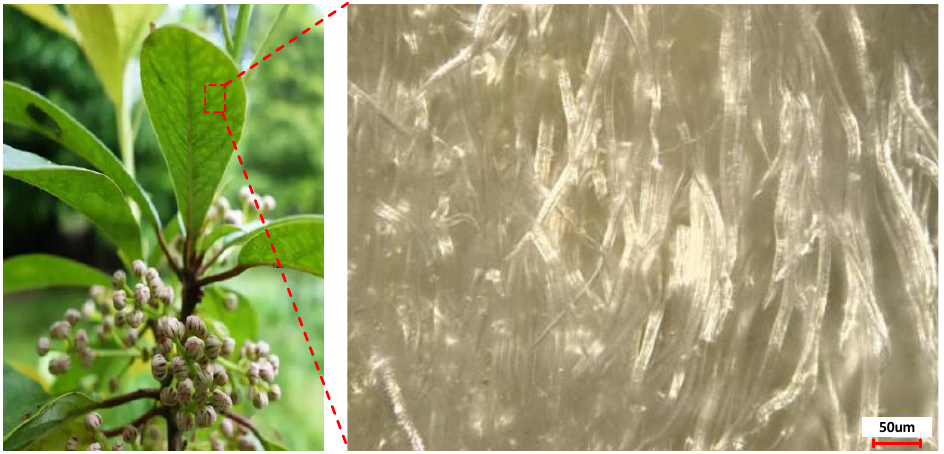
Figure 1. Back micromorphology of DCB leaves.